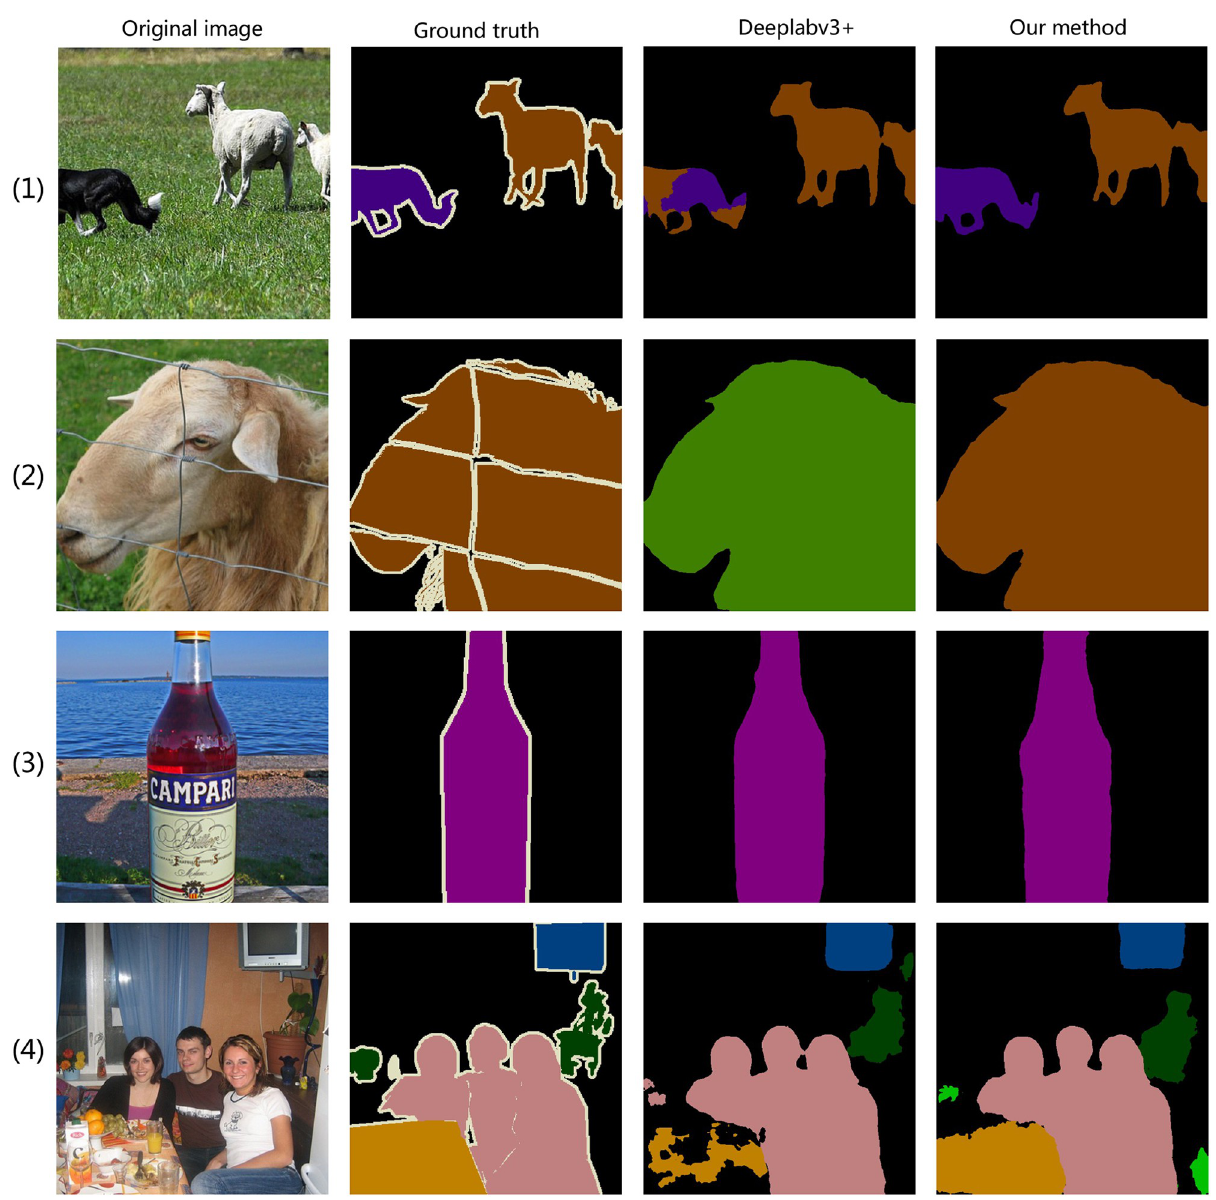
Fig 6. Comparison of DeepLabv3+ and MFEAFN visualization results on PASCAL VOC 2012 validation set.